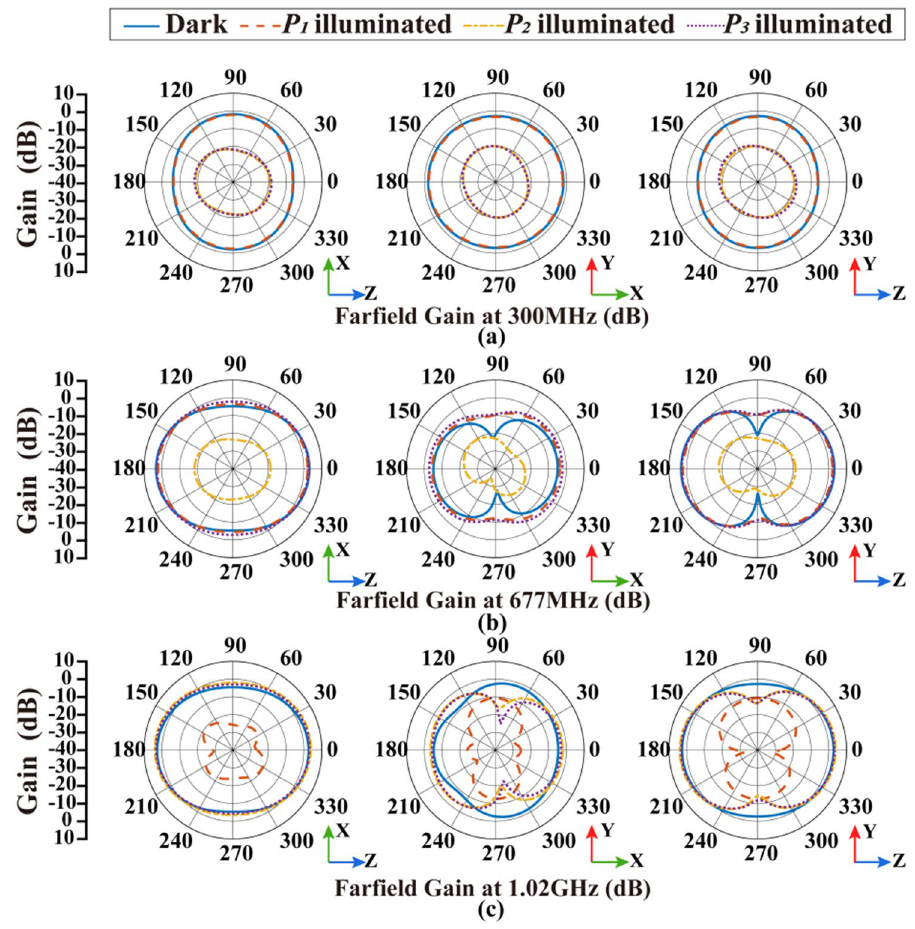
Figure 6. Simulation results of radiation patterns under different illumination conditions: ( a ) radiation pattern at 300 MHz; ( b ) radiation pattern at 677 MHz; ( c ) radiation pattern at 1.02 GHz.